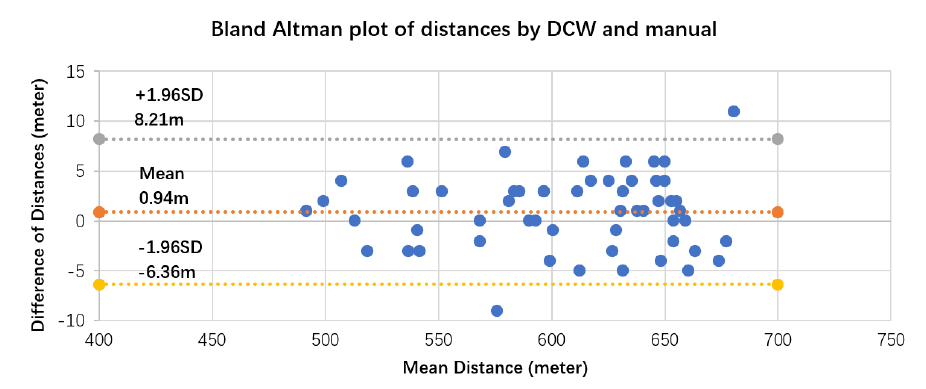
Figure 3. Bland–Altman plot for distance data measured by 3CT and manually measured, with the representation of bias (0.94 m) and limits of agreement (dotted line) from − 1.96SD ( − 6.36 m) to 1.96SD (8.21